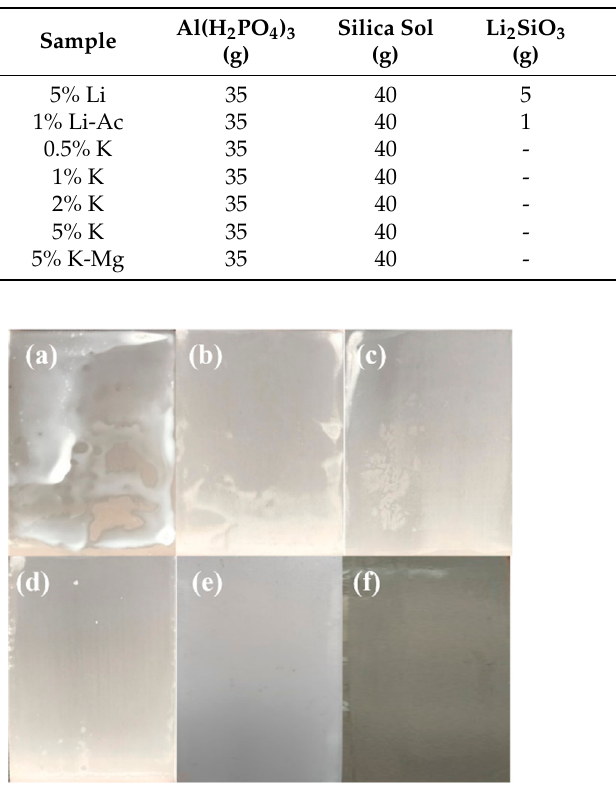
Table 7. The coating with different content of Li 2 SiO 3 or K 2 SiO 3 .